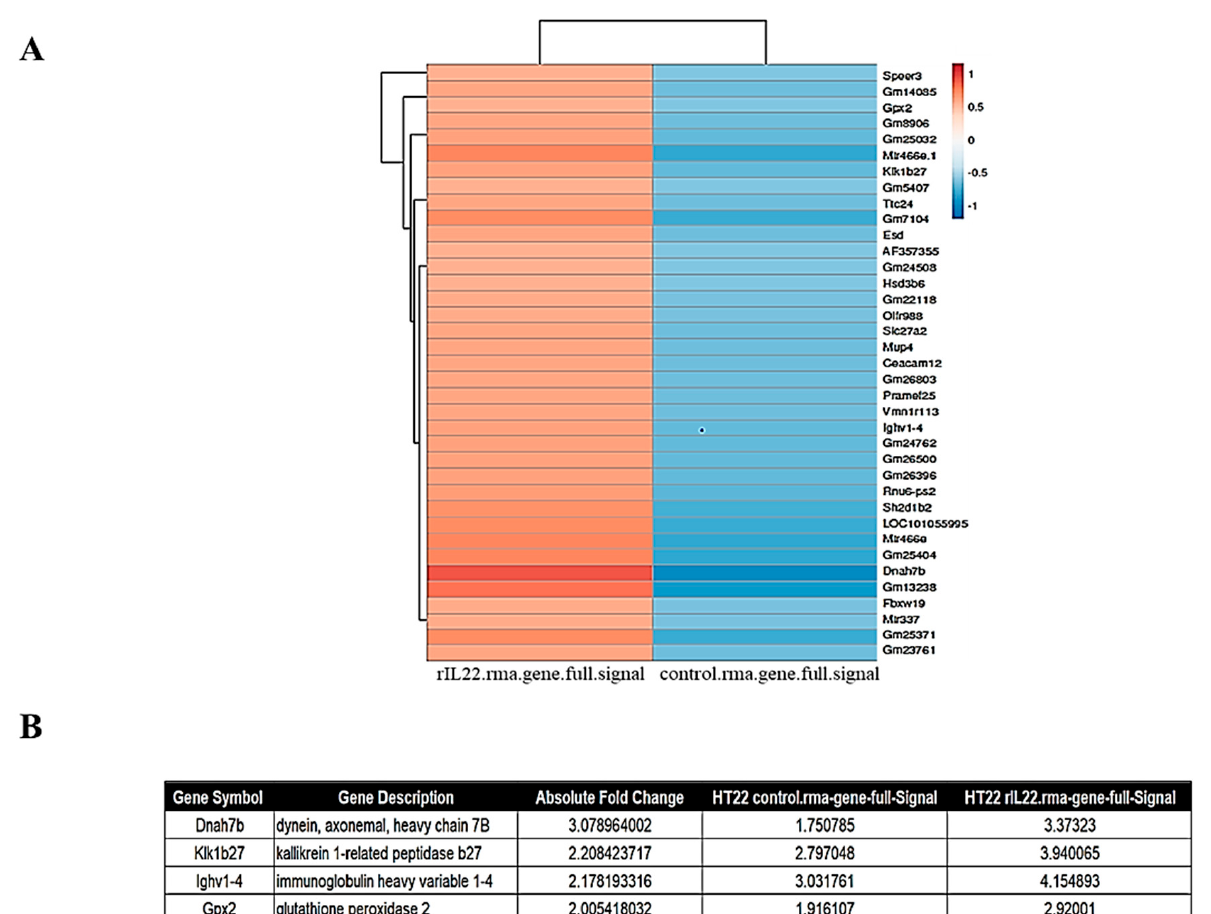
Figure 5. Gene expression profiling of control versus IL-22-treated HT22 cells. ( A ) Heatmap displaying individual differentially expressed genes ( n = 109) by microarray analysis using Affymetrix GeneChip ® Mouse Gene 2.0 ST Arrays. ( B ) Subset of the inflammatory-related genes (Dnah7b, Klk1b27, Ighv1-4 and Gpx2) with large log2 fold-changes between IL-22-treated and control samples ( n = 4).